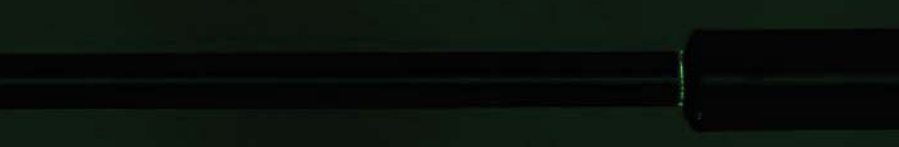
Figure 19. Schematic without any obvious optical transmission